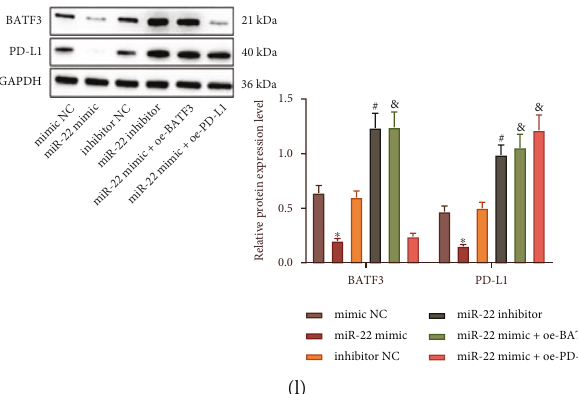
Figure 3: miR-22 diminishes PD-L1 expression via targeting BATF3 in CRC cells. (a) The binding relationship between BATF3 and PD-L1 (namely, CD274) analyzed by hTFtarget database. (b) mRNA expression of BATF3 in CRC tissues and adjacent normal tissues determined by RT-qPCR. (c) Protein expression of BATF3 in CRC tissues and adjacent normal tissues determined by Western blot analysis. (d) The expression of BATF3 in CRC tissues and adjacent normal tissues determined by IHC. (e) Protein expression of BATF3 in FHC and CRC cell lines determined by Western blot analysis. (f) mRNA expression of BATF3 in FHC and CRC cell lines determined by RT-qPCR. (g) mRNA expression of PD-L1 in SW480 cells treated with sh-BATF3-1 or sh-BATF3-2 determined by RT-qPCR. (h) Protein expression of PD-L1 in SW480 cells treated with sh-BATF3-1 or sh-BATF3-2 determined by Western blot analysis. (i) The binding site of miR-22 in the 3 ′ UTR of BATF3 mRNA predicted using TargetScan website. (j) The binding of miR-22 to BATF3 con fi rmed by dual-luciferase reporter assay. (k) The expression of miR-22, BATF3, and PD-L1 in SW480 cells treated with miR-22 mimic, miR-22 inhibitor, miR-22 mimic+OE-BATF3, or miR-22 mimic+OE-PD-L1 determined by RT-qPCR. (l) The protein expression of BATF3 and PD-L1 normalized to GAPDH in SW480 cells treated with miR-22 mimic, miR-22 inhibitor, miR-22 mimic+OE-BATF3, or miR-22 mimic+OE-PD-L1 determined by Western blot analysis. ∗ p < 0 : 05 vs. adjacent normal tissues, FHC cell line, HEK293T cells transfected with mimic NC, or SW480 cells treated with sh-NC or mimic NC. # p < 0 : 05 vs. SW480 cells treated with inhibitor NC. & p < 0 : 05 vs. SW480 cells treated with miR-22 mimic. The cell experiment was run in triplicate